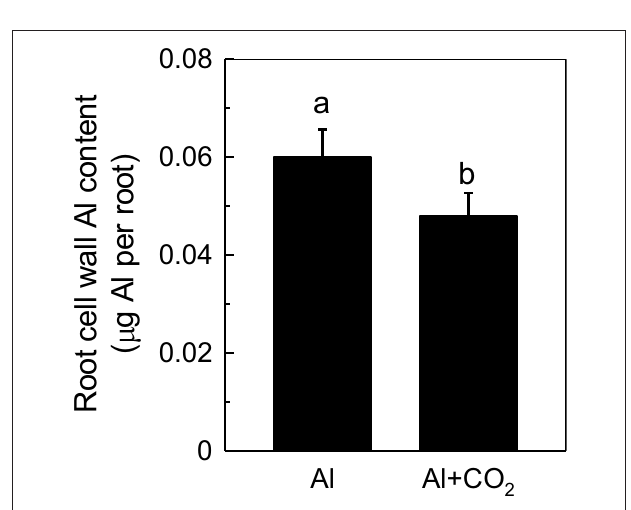
FIGURE 4 | Effects of elevated CO 2 treatment on root cell wall Al accumulation in Kas. Three-day-old rice seedlings were treated with 0.5 mM CaCl 2 solution with or without 50 µ M Al under ambient (400 µ L · L − 1 ; CK) or elevated (600 µ L · L − 1 ; CO 2 ) CO 2 for 24 h (pH 4.5). The root apex was excised for cell wall extraction. Data are means ± SD ( n = 4). Columns with different letters are significantly different at P <